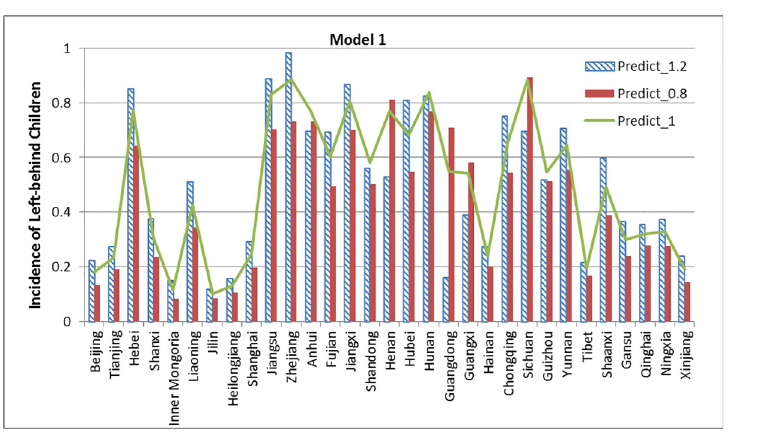
Fig 20. Simulation results of Model 1.